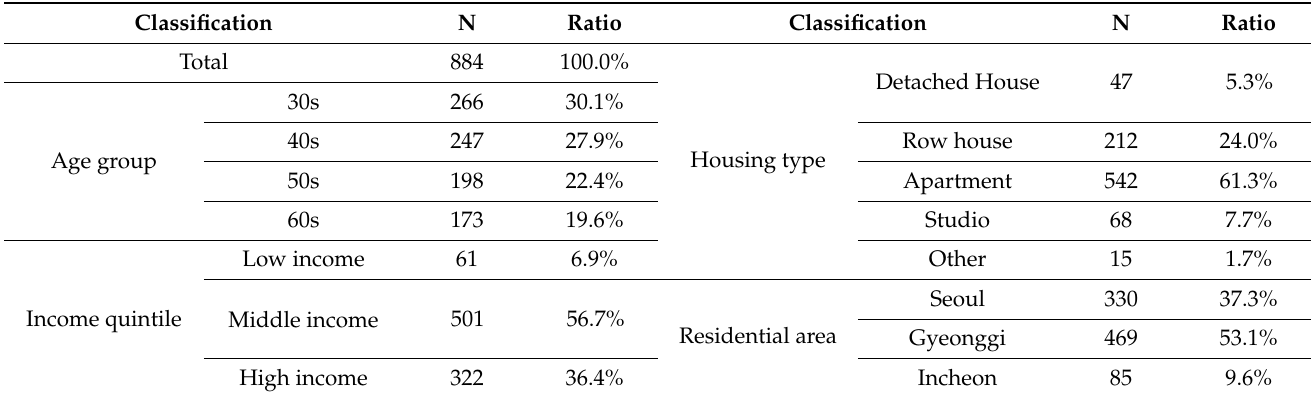
Table 3. Demographic attributes of